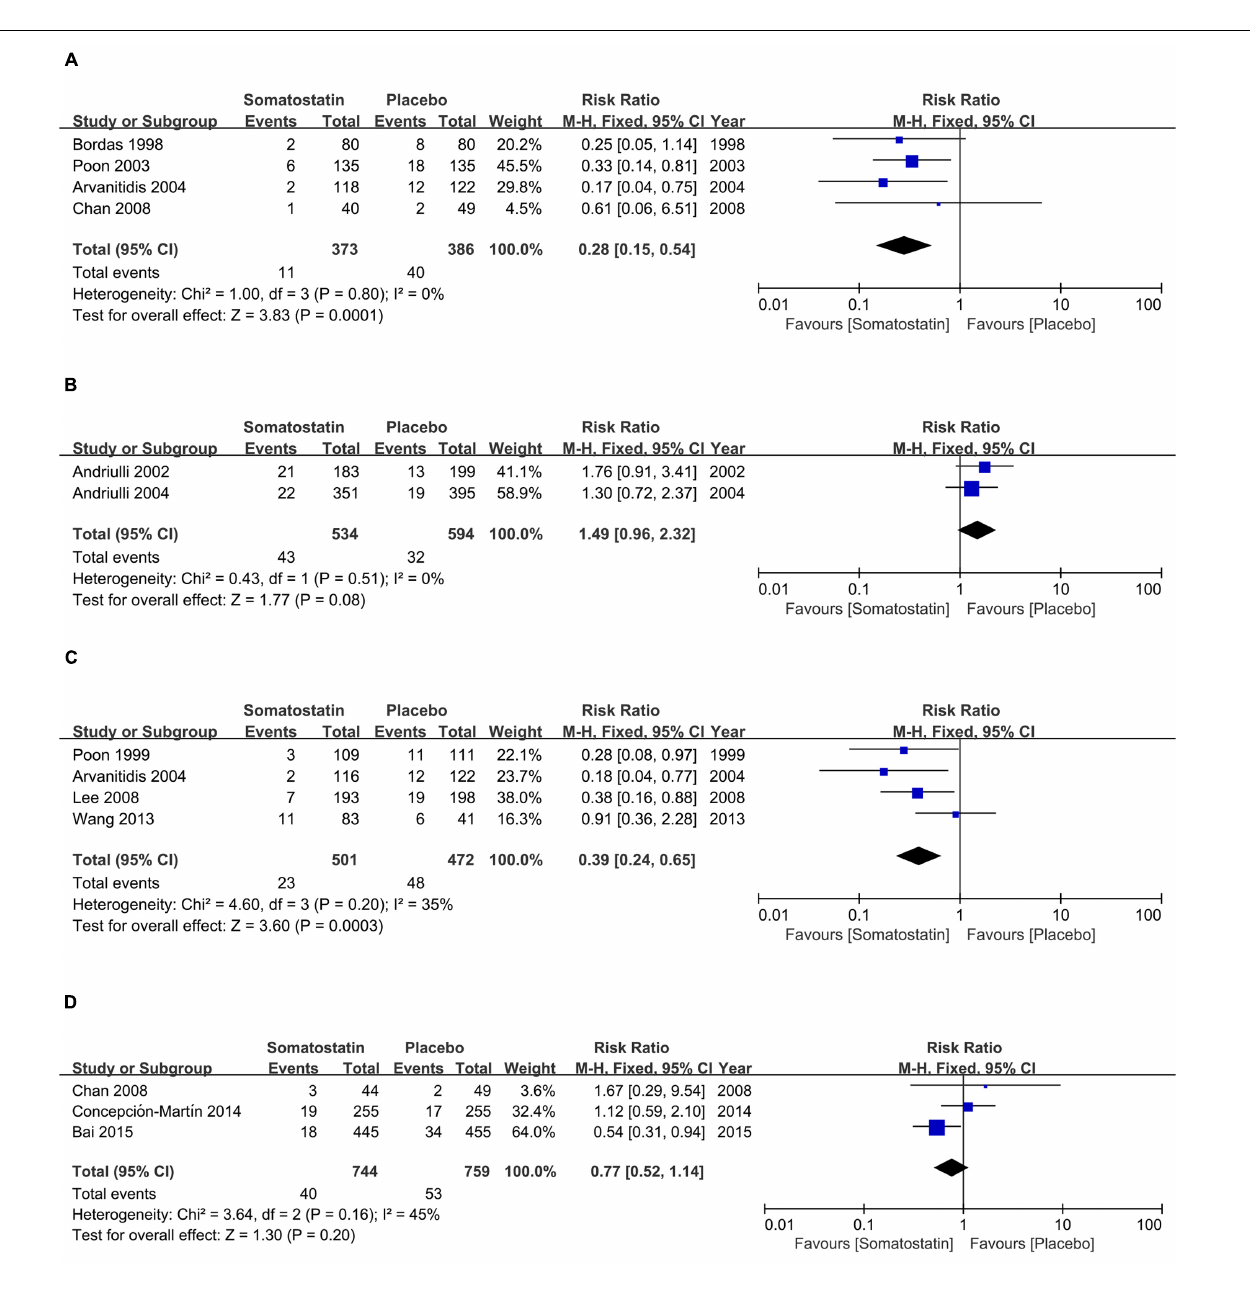
FIGURE 3 | Forest plot of RR of PEP in patients treated with SOM as single bolus (A) , short-term infusion (B) , long-term infusion (C) , and bolus plus continuous infusion (D) . I 2 and P is the criterion of heterogeneity test, (cid:7) pooled risk ratio, — (cid:4) — risk ratio and 95% CI.